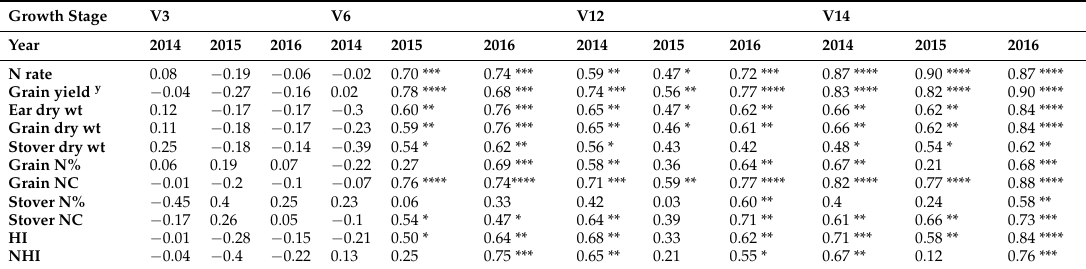
Table 1. Pearson correlation between maize GlnLux glutamine and end-season measurements z . Growth Stage